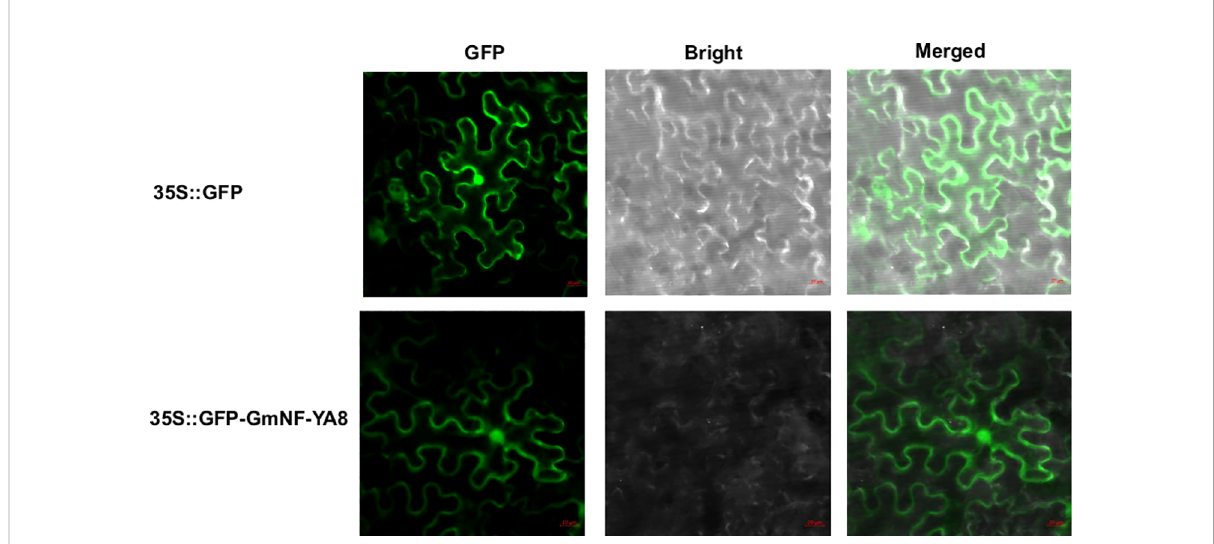
FIGURE 4 GmNF-YA8 is localized in the nucleus and plasma membrane. GFP signal was detected in transformed Nicotiana benthamiana leaf epidermis cells at 488 nm by laser confocal miscroscopy. GFP: GFP channel; Bright: light channel; Merged: the overlap of GFP channel and light channel. 35S::GFP: pMDC43 empty vector containing GFP; 35S::GFP-GmNF-YA8: pMDC43- GmNF-YA8 vector containing the fusion of GFP with GmNF-YA8.